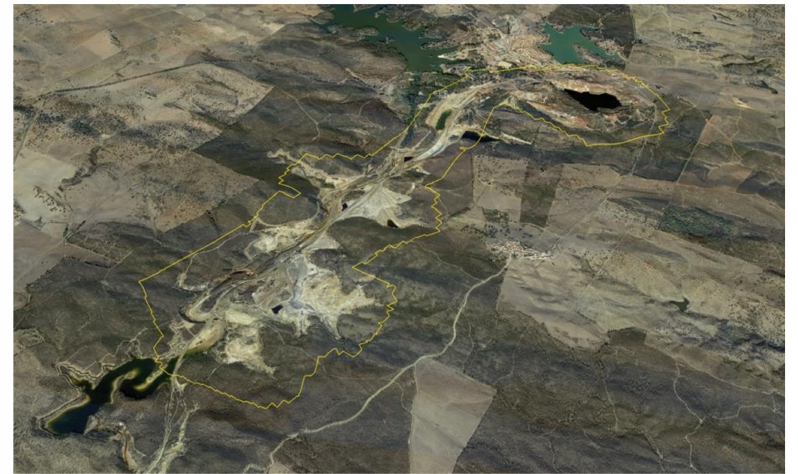
Figure 2. Aerial view of the S ã o Domingos mining area. The yellow line represents the boundaries of the section surveyed by the UAV (Imagery from Google Earth). Location approximately at coordinates 37.65965 lat., − 7.50506 long. (WGS